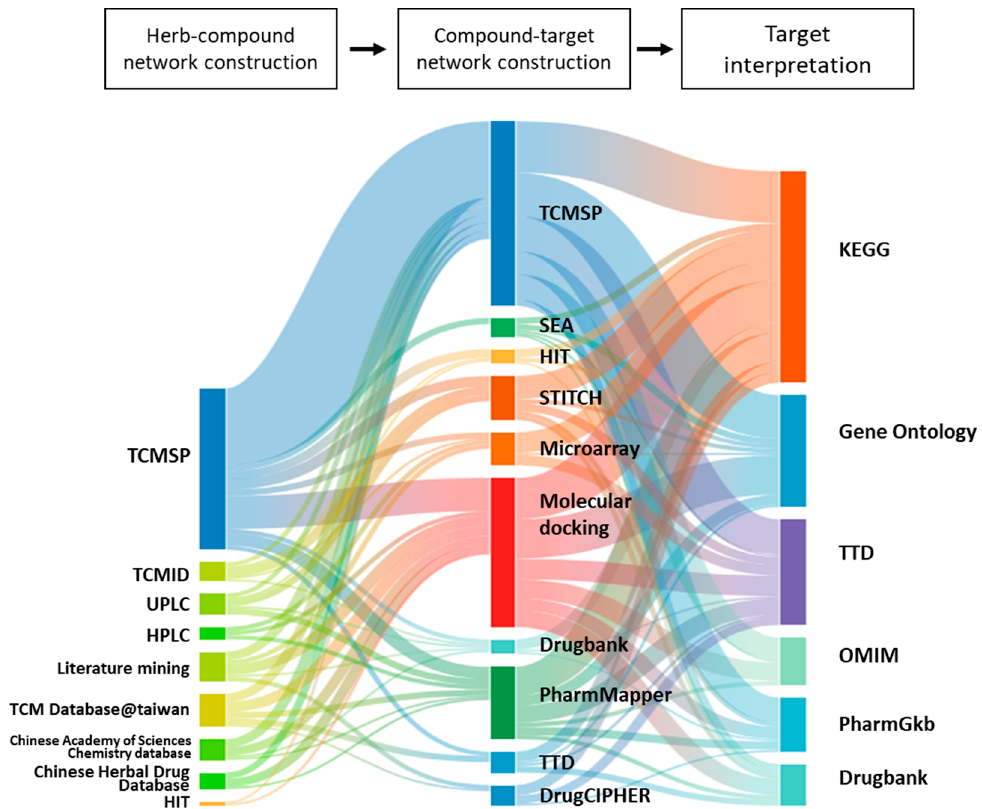
Figure 7. The combinatorial pattern of tools and databases employed in THM-NP studies. Each layer represents the process of network pharmacology analysis of herbal medicines, and the components of each layer represent the employed tools and databases. A connecting line between components indicates that the connected tools and databases are used together in the same THM-NP studies. The thickness of each connecting line indicates the frequency with which the two methodologies are used together in the THM-NP studies. TCMSP, Traditional Chinese Medicine Systems Pharmacology Database; TCMID, Traditional Chinese Medicine Integrated Database; HIT, Herb Ingredients’ Targets; KEGG, Kyoto Encyclopedia of Genes and Genomes; TTD, Therapeutic Target Database; OMIM, Online Mendelian Inheritance in Man.